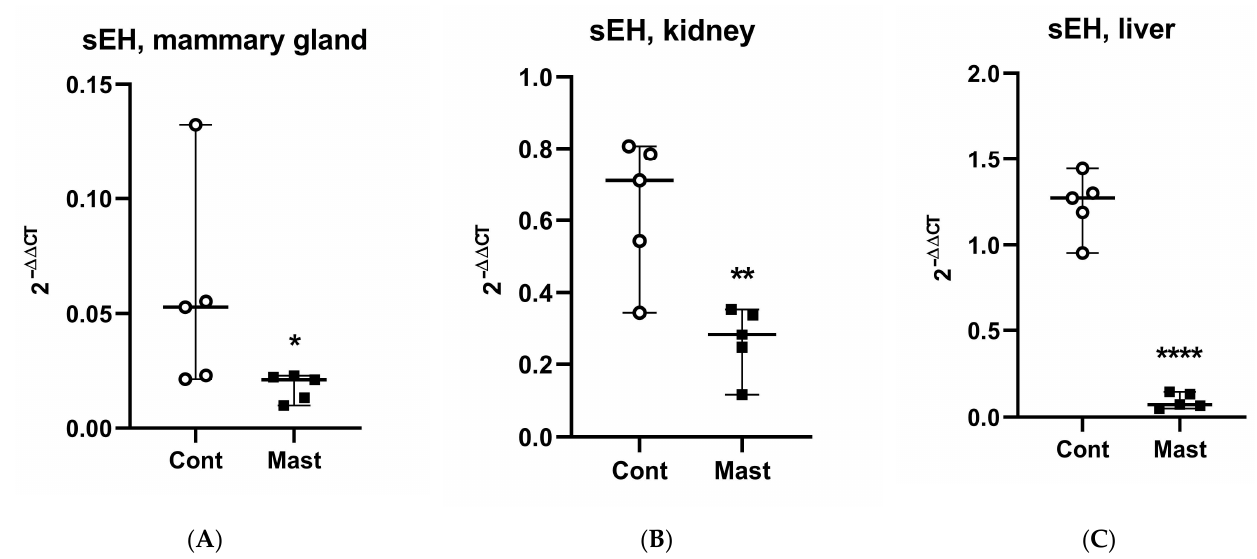
Figure 2. Relative expression of soluble epoxide hydrolase (sEH) mRNA (median and range) in tissues: ( A ) mammary gland, ( B ) kidney, ( C ) liver from dairy cows with systemic coliform mastitis ( n = 5) and matched control dairy cows with no overt clinical disease ( n = 5). Data were analyzed with Wilcoxon rank-sum tests ( α = 0.05). * p < 0.05, ** p < 0.01, **** p < 0.0001.